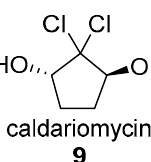
Figure 6. Overview on the categorization of halogenating enzymes.